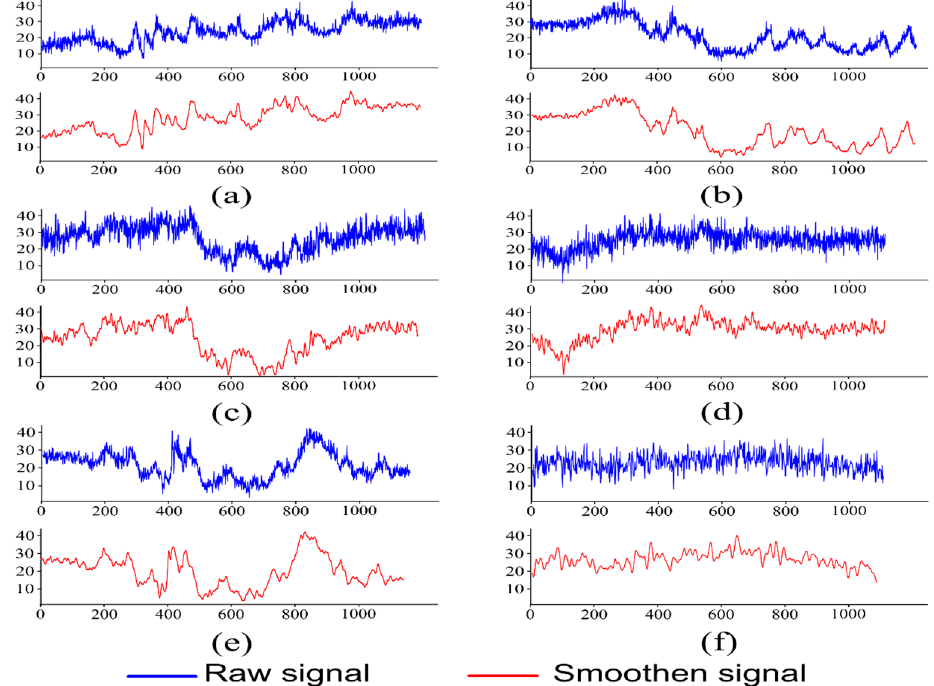
Figure 2. Raw and smoothing CSI signal visualization of some interactions, i.e., ( a ) Approaching, ( b ) Departing, ( c ) Handshaking, ( d ) High five, ( e ) Hugging, ( f ) Steady state.